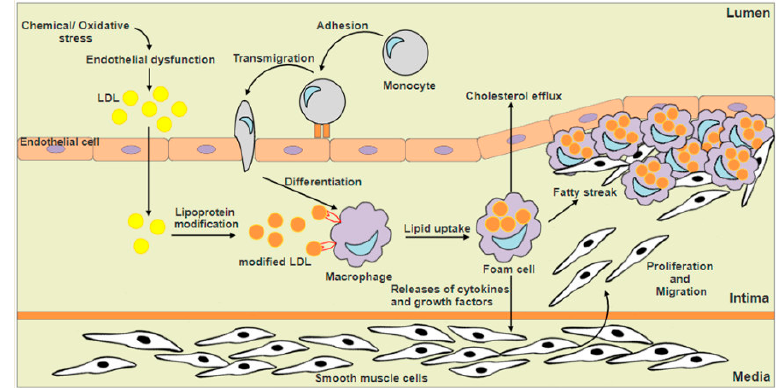
Figure 1. Macrophage foam cells formation and fatty streak development. Increased reactive oxygen species (ROS) production and oxidative stress induce endothelial dysfunction, which increases the permeability of endothelium and allows for the entry of low density lipoproteins (LDL) into the arterial intima layer. LDL within the intima layer may undergo oxidative modification, which results in endothelial cell activation, leading to the expression of chemoattractant factors and cytokines that facilitate the recruitment of monocytes from lumen into the arterial intima. Upon entering the arterial intima, monocytes are differentiated into macrophages which may internalize modified LDL, creating a foamy appearance within the macrophages, also known as foam cells. Macrophage foam cells produce a variety of cytokines and growth factors that stimulates the infiltration and proliferation of smooth muscle cells from the media to the arterial intima, which results in the thickening of the arterial walls where they transform the fatty streak into a stable